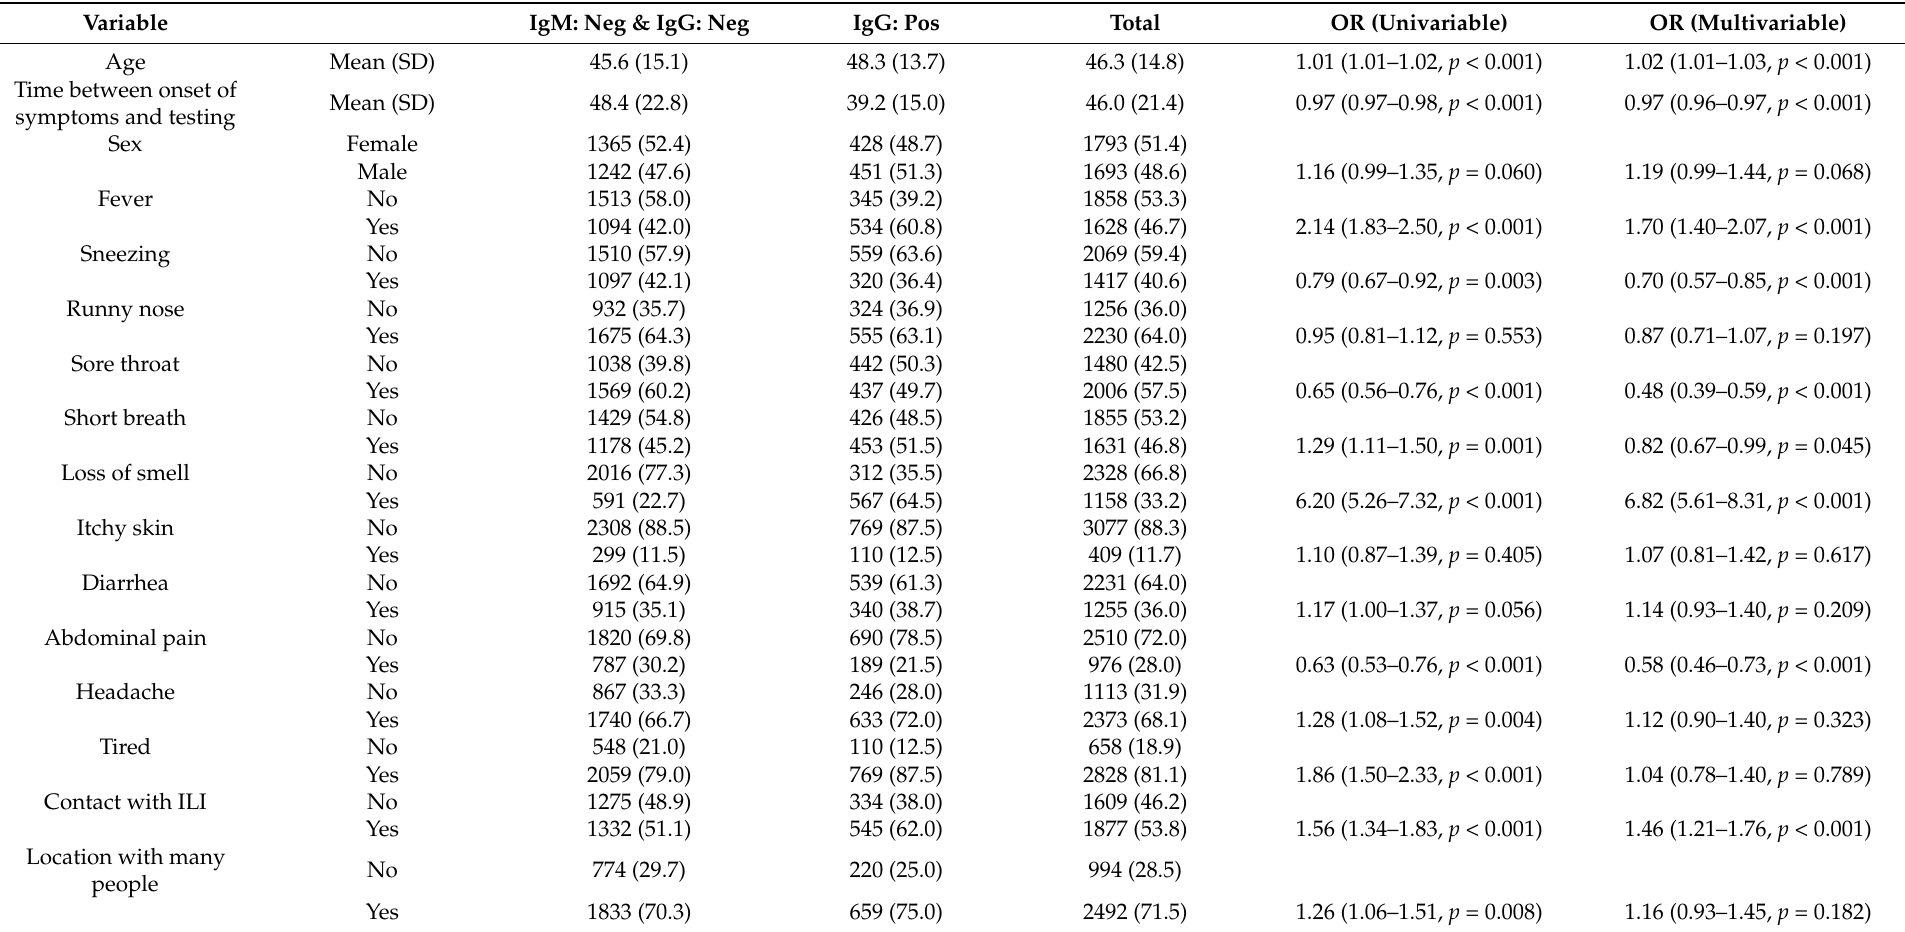
Table 3. Comparison between IgM, IgG negative persons (first day of symptoms longer than 14 days) compared to IgG positive